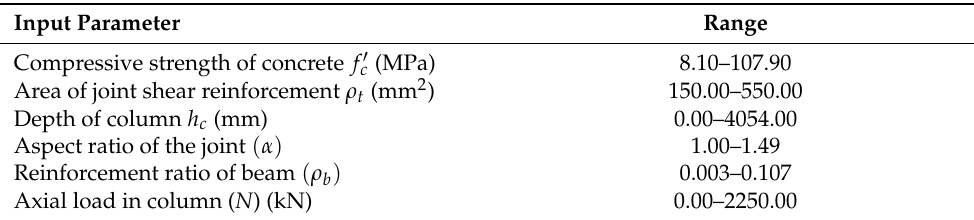
Table 1. Range of input